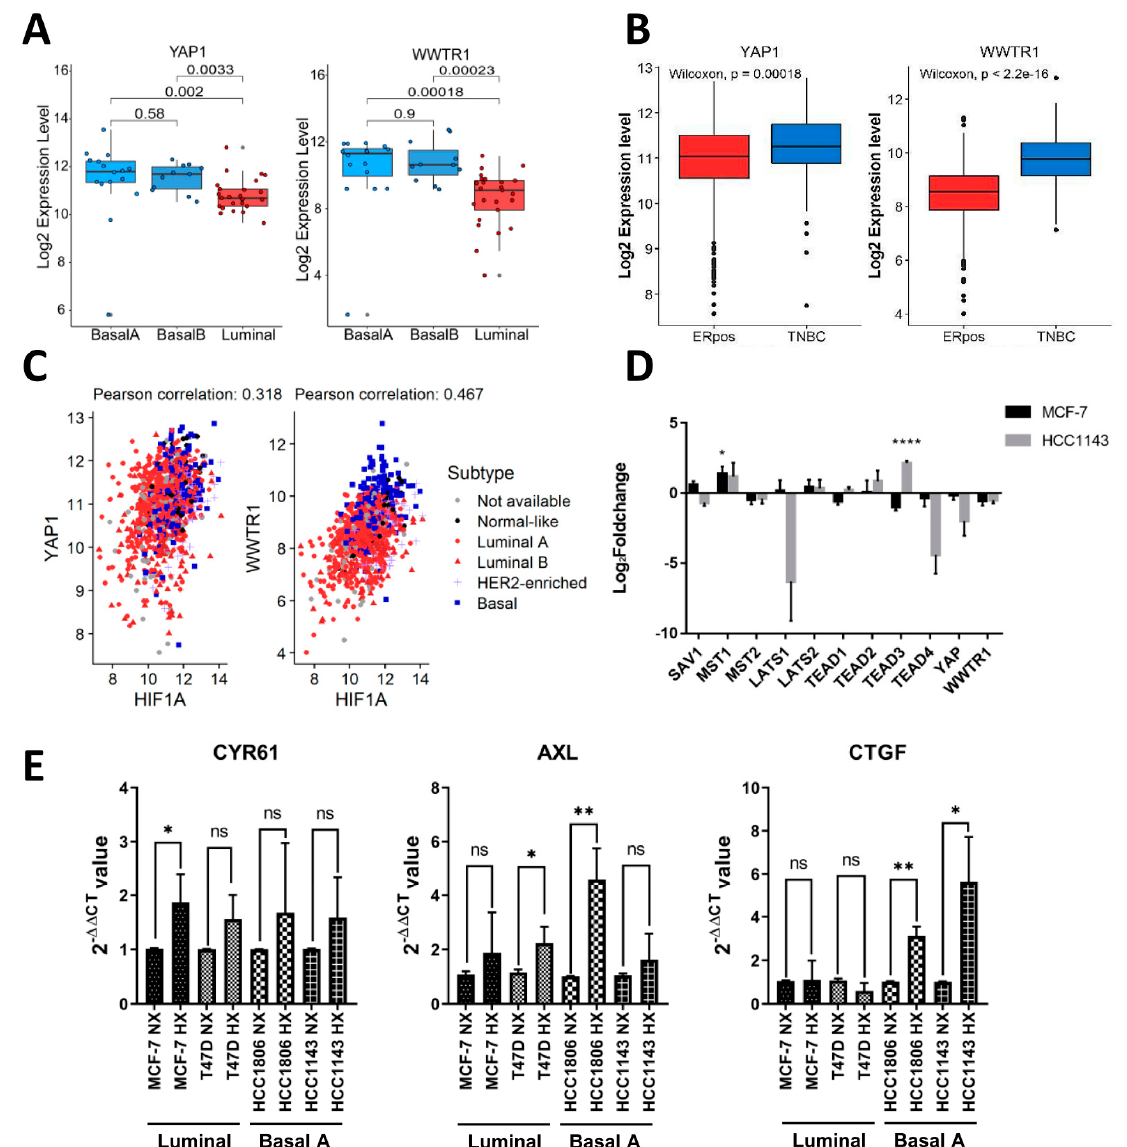
Figure 2. Expression of YAP and TAZ in breast cancer cell lines and tumors. ( A ) RNA expression level of YAP and TAZ (WWTR1) from RNA-Seq data for 52 human breast cancer cell lines classified by luminal − , basal A − , or basal B − like subtype [33]. p-value calculated using One − way ANOVA. ( B ) Log 2 RNA expression levels of YAP and TAZ in ER positive and TNBC clinical samples. p-value calculated using Wilcoxon signed-rank test. ( C ) Correlation between RNA expression levels for HIF1 α and YAP and for HIF α and TAZ determined using cBioPortal data from basal-like, HER2 enriched, luminal A and luminal B breast cancer subtypes. ( D ) Expression of YAP, TAZ, TEAD1–4, and upstream kinases in the Hippo signaling cascade determined in TempO-Seq data. Log 2 foldchange under hypoxia relative to normoxia is shown in MCF7 and HCC1143. Mean and SD of triplicate measurements is shown. *, padj < 0.05; ****, padj < 0.0001. ( E ) qPCR experiment showing expression of the indicated YAP/TAZ targets genes in the indicated luminal and basal A TNBC cell lines exposed to normoxia or hypoxia after 5 days. Mean expression relative to β− actin is shown. Error bars indicate SD for triplicate measurements. *, p < 0.05; **, p < 0.01; ns, not significant.